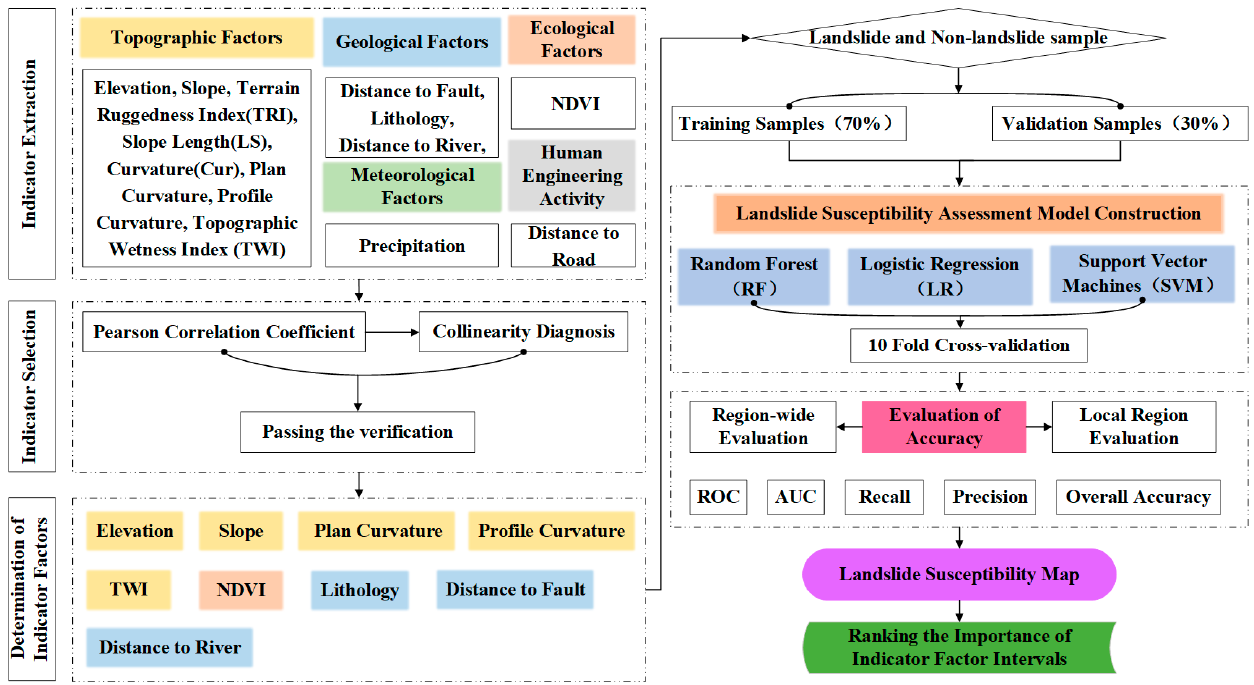
Figure 4. Flowchart showing the methodology of the present work.